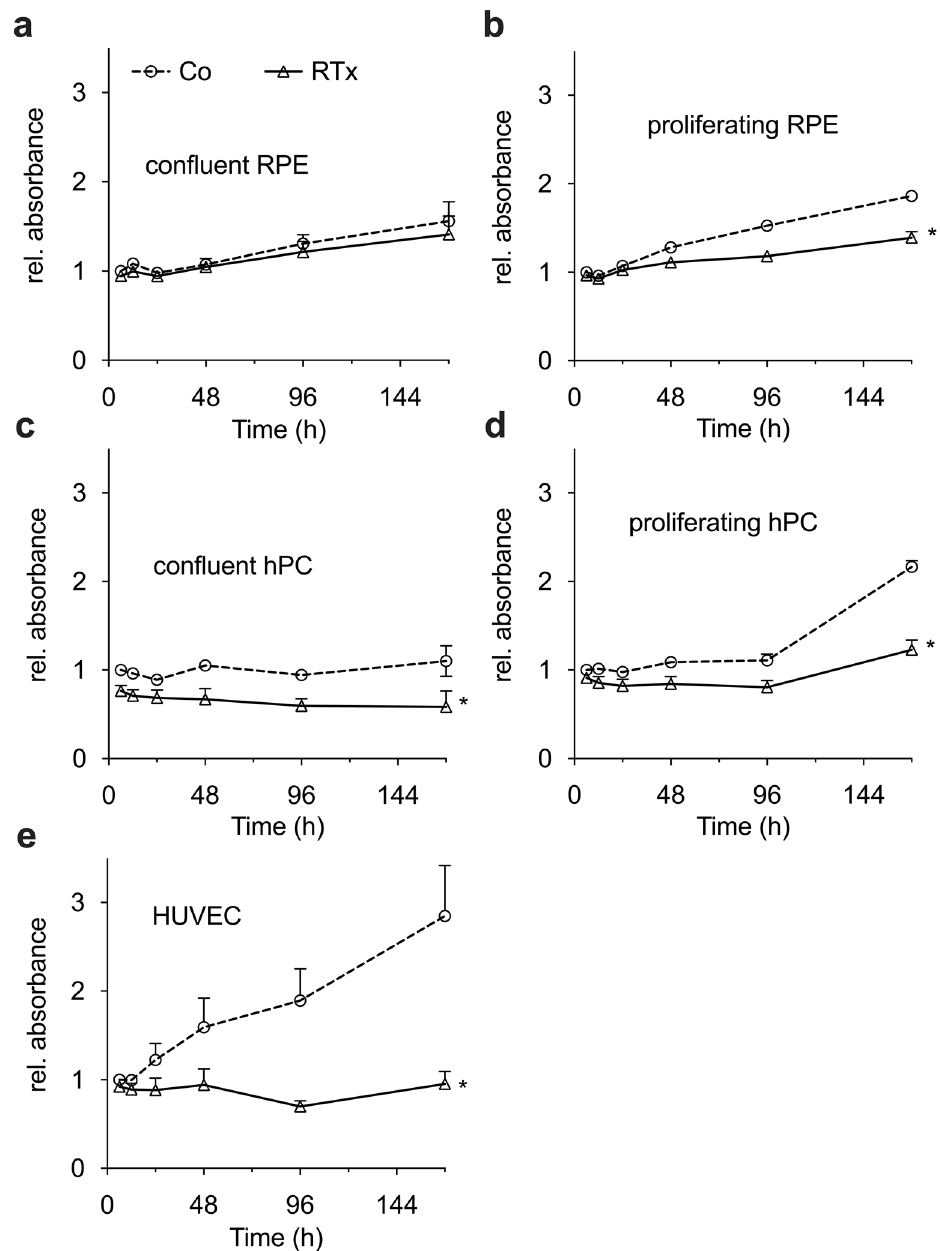
Figure 2. Irradiation reduces cell viability of RPE, hPC and HUVEC. Human RPE, hPC and HUVEC cultured under permissive or not-permissive conditions were irradiated with 16 Gy. XTT cell viability assay was performed at various times after treatment and plotted as relative fold change to the untreated control group 6 h after treatment. *p < 0.05; n = 16 of two independent experiments. Co: untreated control group; RTx: irradiated group; Figure was created using Graph Pad Prism 8 (Version 8.4.3.; www. graph pad.